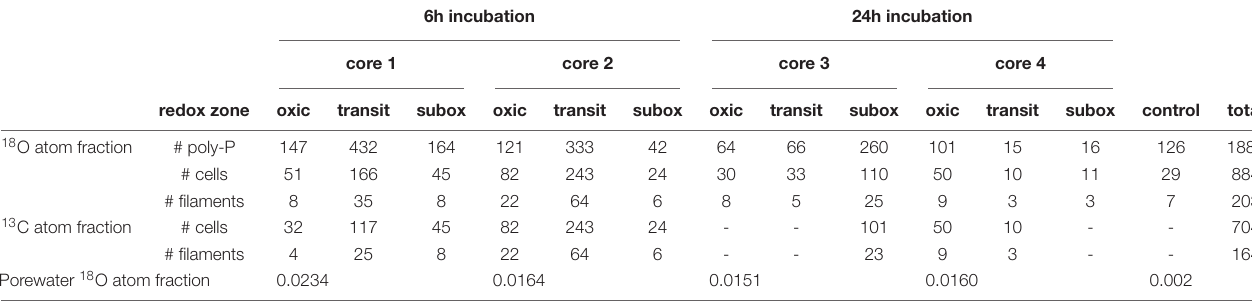
TABLE 1 | Number of poly-P granules, cells and filament fragments measured in this study.